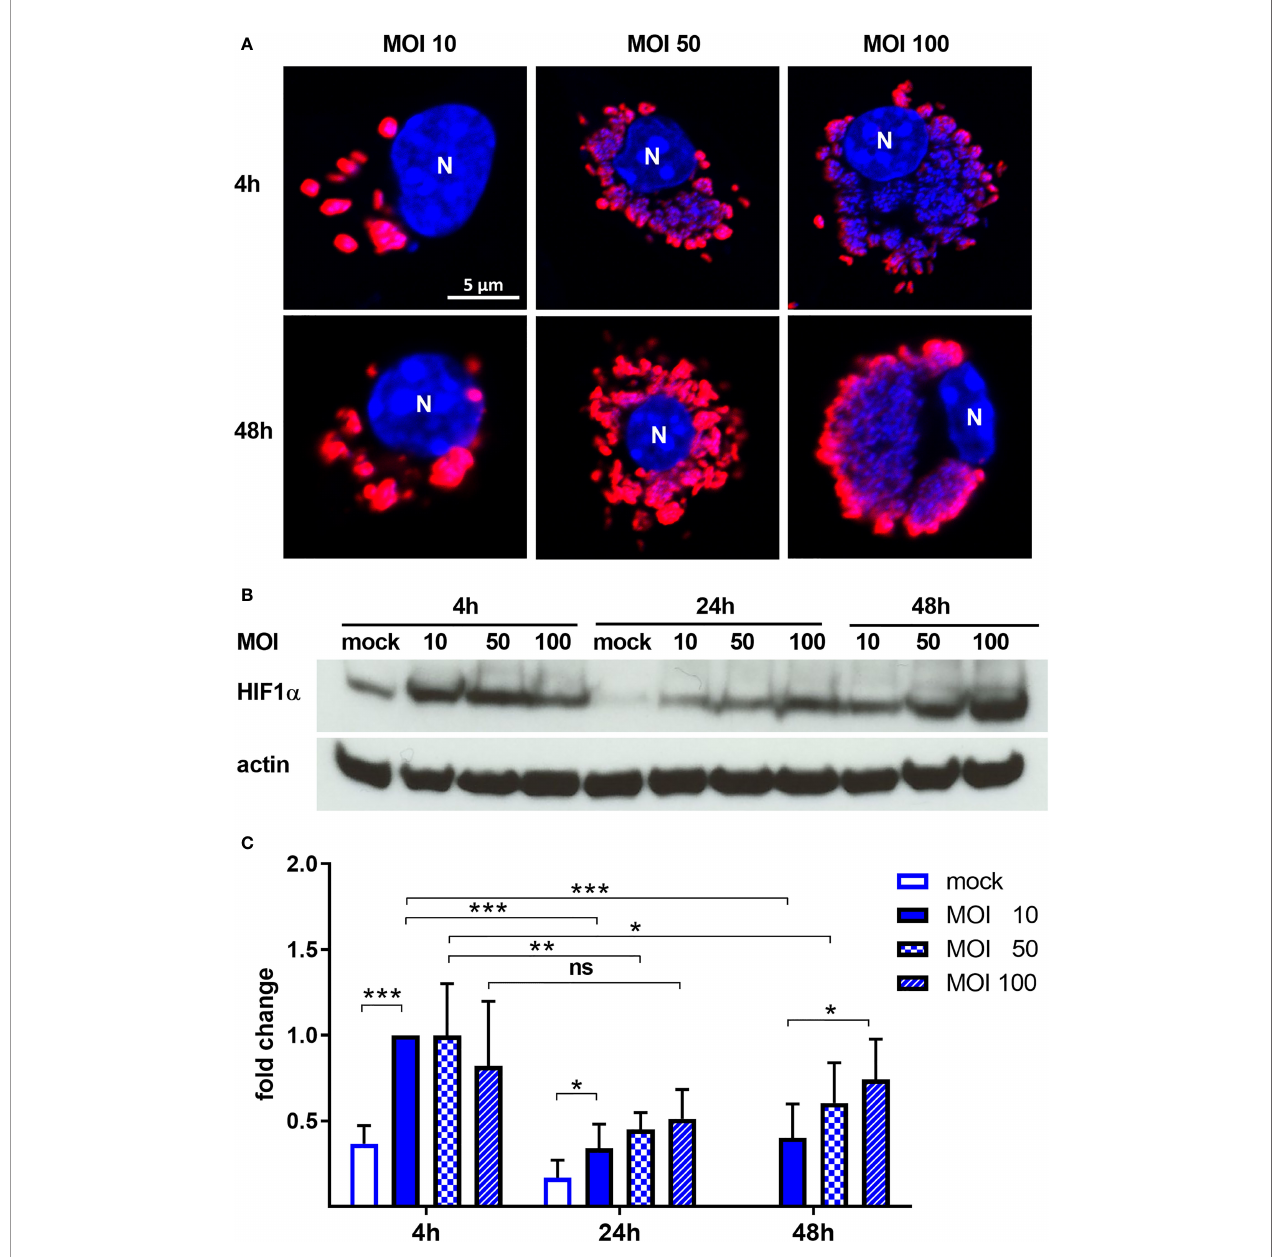
FIGURE 2 | C. burnetii intensi fi es HIF1 a stabilization under hypoxia in a dose-dependent manner. (A) Representative immuno fl uorescence micrographs of murine BMDM infected with C. burnetii for 4 and 48 h under hypoxia at MOI 10, 50 or 100. The cells were fi xed, permeabilized and stained with DAPI (blue) and anti- C. burnetii (red). N = nucleus. (B, C) BMDM infected with C. burnetii for 4, 24 and 48 h under hypoxia at MOI 10, 50 or 100 were analyzed by immunoblot using antibodies against HIF1 a and actin as loading control. Importantly, uninfected BMDMs were only cultivated for 24 h under hypoxia, as cell viability was signi fi cantly reduced at later time points. (B) One representative immunoblot from 4 independent experiments is shown. (C) Densitometric analysis of the HIF1 a /actin ratio was performed using ImageJ. Fold changes are shown relative to cells infected with MOI of 10 for 4 hours. Mean ± SD, n=6, one-sample t-test or t-test. ***p < 0.001, **p < 0.01, *p < 0.05, ns = p >